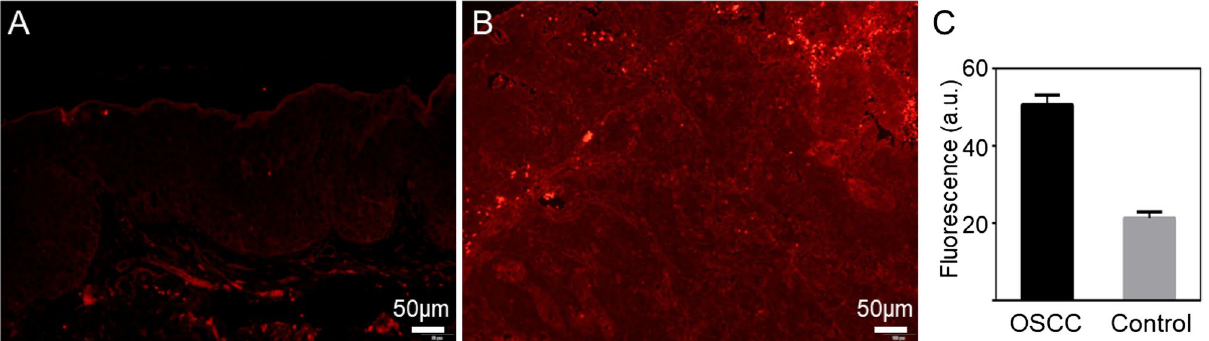
Figure 1. Immunofluorescence assay of paraffin sections from ( A ) normal oral mucous tissue and ( B ) OSCC tissue. ( C ) Quantitation of GRPR